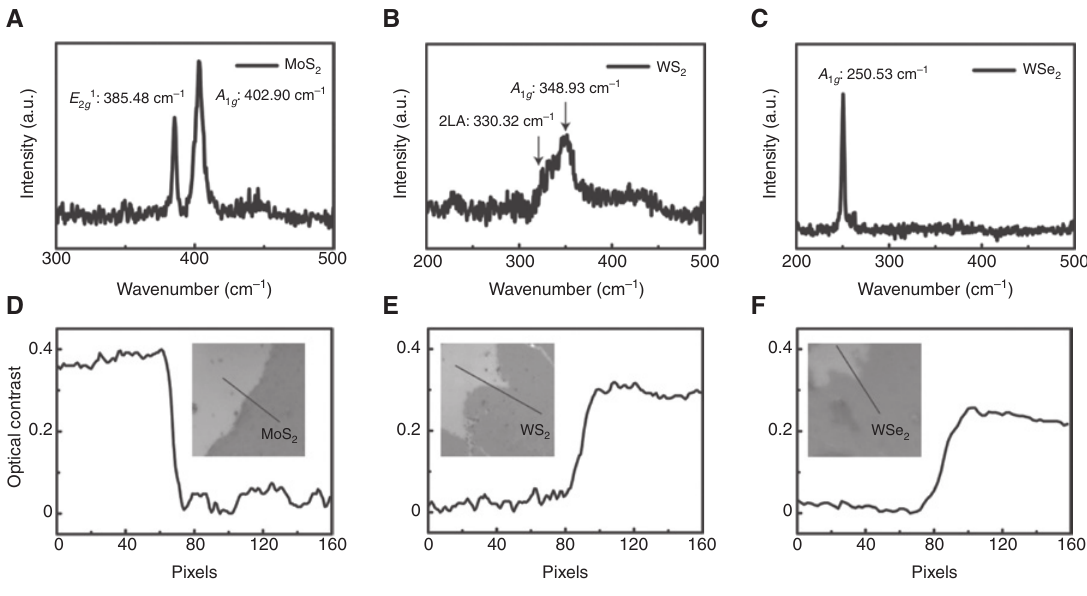
Figure 2: Confirmation of monolayer TMDCs. Raman spectra of monolayers of (A) MoS black lines in the optical images in the